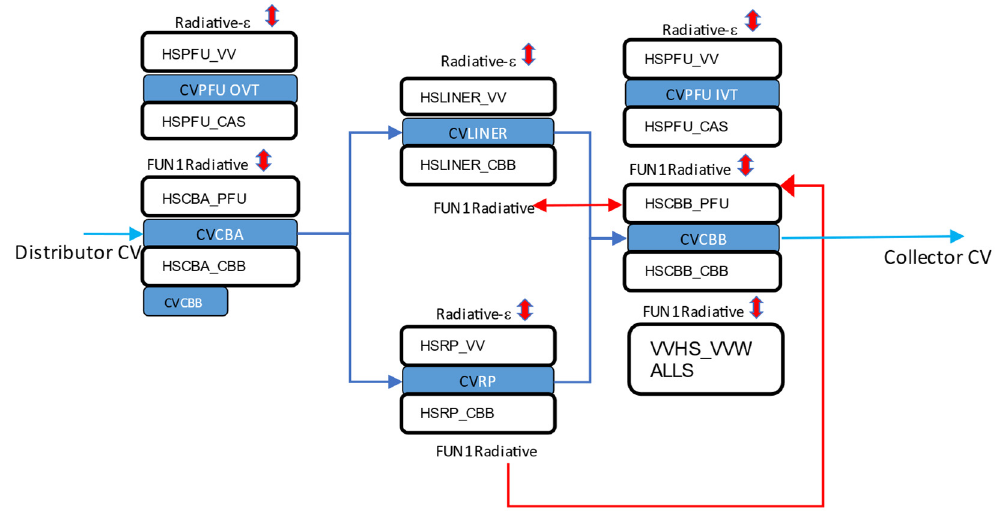
Figure 6. Overview of divertor in-VV volumes system nodalization: detailed volumes for PFU and cassette, related heat structures and related coupling. Control Volumes (CV) are shown as blue- shaded boxes, Heat Structures (HS) are shown as white boxes, blue arrows show the water flow in normal conditions, red arrows show heat transfer mechanisms modeled across HS (FUN1 functions) or radiative towards plasma chamber.